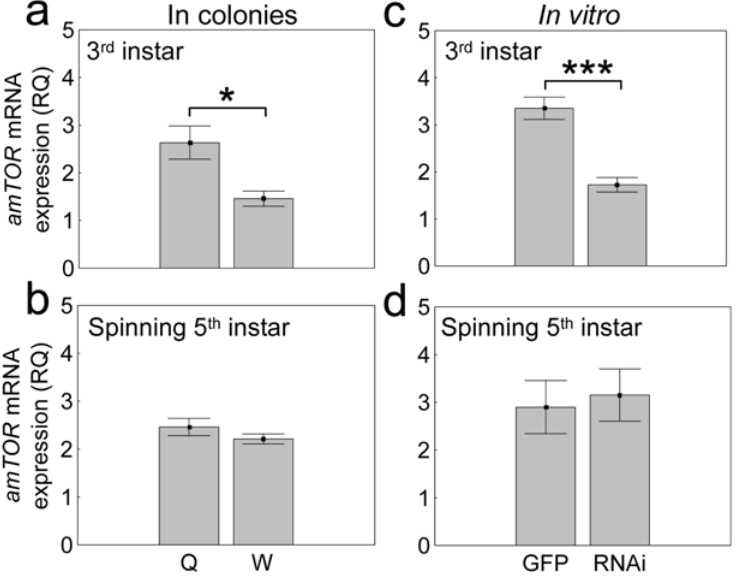
Figure 2. Relative quantities (RQ) of amTORmRNA levels in honey bee larvae. In colonies a–b, queen- (Q) and worker-destined (W) larvae are characterised by a transient two-fold difference in amTOR expression (present in 3 rd instar larvae, absent in spinning 5 th instar larvae). In vitro c–d, RNAi was calibrated to decrease amTOR about two-fold in 3 rd instar knockdowns (RNAi) vs. controls exposed to GFP derived dsRNA (GFP). Suppression was transient, as often observed with RNAi. Thereby natural expression patterns of amTOR were mimicked (a–b vs. c–d). Bars are means 6 s. e. (asterisk P , 0.01, three asterisks P , 1.0 10 2 6 ).